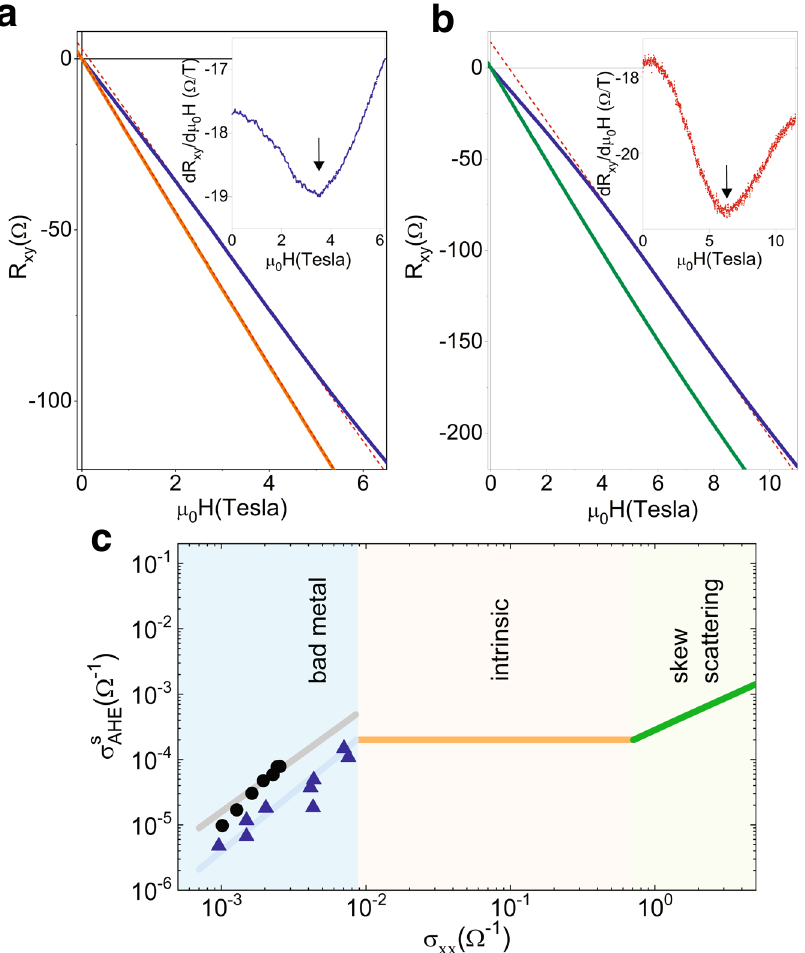
Fig. 2 Analysis of the anomalous Hall effect. Transverse (Hall) resistance R xy as a function of the magnetic fi eld of: ( a ) sample A at two gate voltages (Vg = + 60 V (blue line), Vg = − 25 V (orange line)) and 2 K; ( b ) sample B at Vg = + 30 V (2 K (blue line) and 20 K (green line)). Corresponding 2 K dR xy = d μ 0 H data are shown in the insets of each fi gure, with the arrow indicating the minimum. The minimum of the dR xy = d μ H is the slope of the red dashed lines fi tting the data in the intermediate 3-4 Tesla range. The intercepts of these lines are the AHE 0 components at saturation. c Anomalous Hall conductivity vs. longitudinal 2D conductivity (see main text Eq. (1)). Black dots and blue triangles refer to the two LAO/ETO/STO samples. Full lines refer to the exponent α in the relation σ AHE / σ xx ð Þ α : α = 1.8 (light blue, and gray, intrinsic AHE suppressed by disorder), α = 0 (orange, intrinsic AHE), α = 1(green, skew